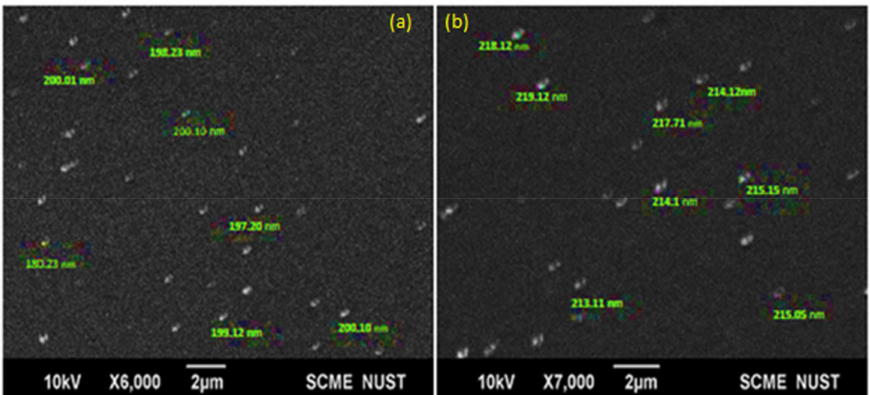
Figure 2. Scanning electron microscopy (SEM) images of ( a ) blank nanoparticles and ( b ) cefotaxime- loaded PCL